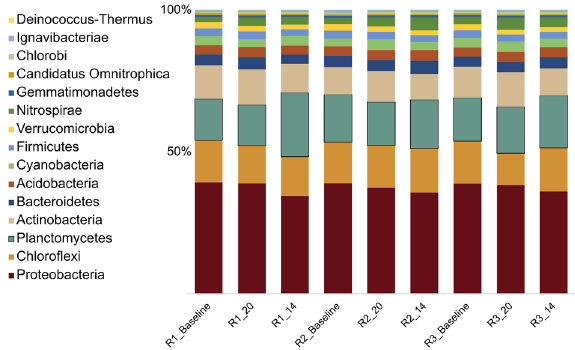
Fig. 3 Microbial community composition. Relative abundance of the top 15 bacterial phyla of the bio fi lm carrier community derived from taxonomic assignment of metagenomic sequence reads using Kaiju. Labels denote Reactor (R1, R2, R3) and time of sampling, _Baseline (Pooled from 20 °C and 14 °C experiment), _20 (after the 20 °C experiment), _14 (after the 14 °C experiment). Colors represent the different bacterial